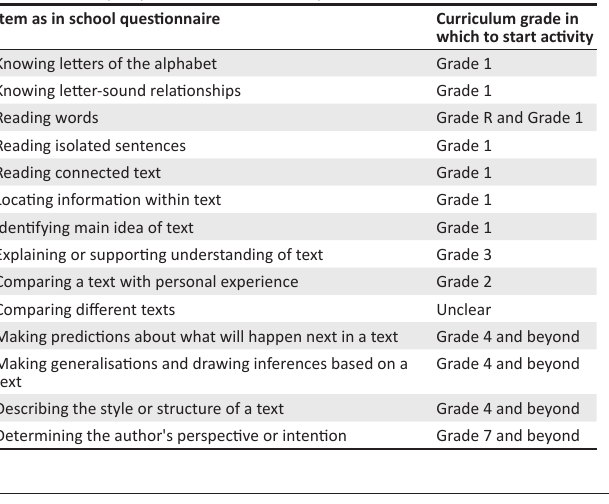
TABLE 3: Principal questions as classified by the curriculum statement.